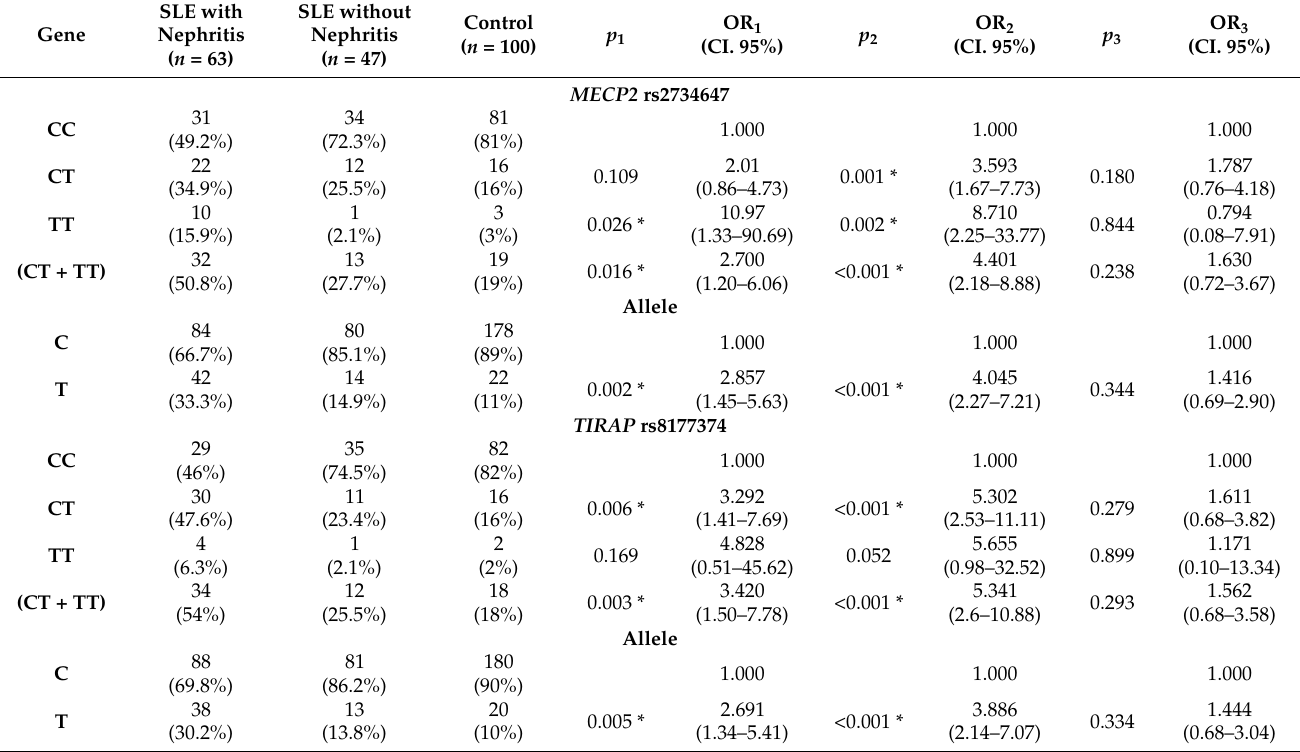
OR 1 : Odds ratio for patients with and without nephritis. OR 2 : Odds ratio for patients with nephritis and controls. OR 3 : Odds ratio for patients without nephritis and controls. CI: confidence interval; LL: lower limit; UL: upper limit. *: Statistically significant at p ≤ 0.05. p 1 : p value for comparing between with nephritis and without nephritis. p 2 : p value for comparing between with nephritis and control. p 3 : p value for comparing between without nephritis and